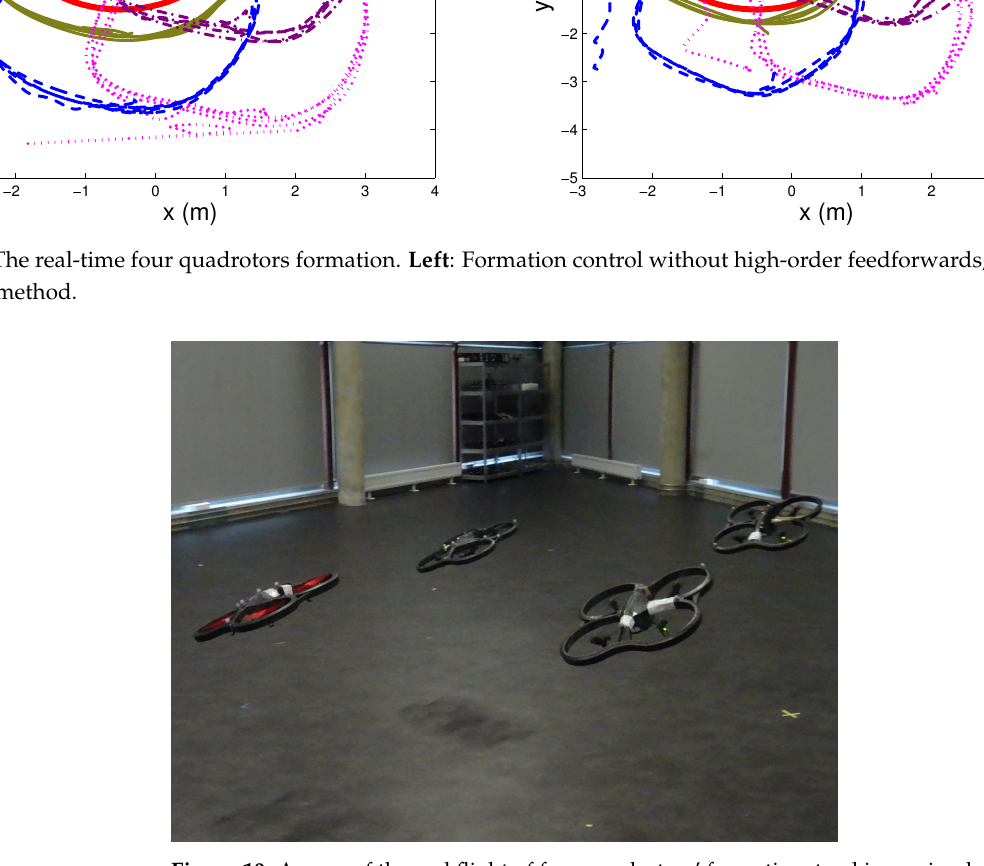
Figure 10. A snap of the real flight of four quadrotors’ formation, tracking a circular trajectory while maintaining a rectangle